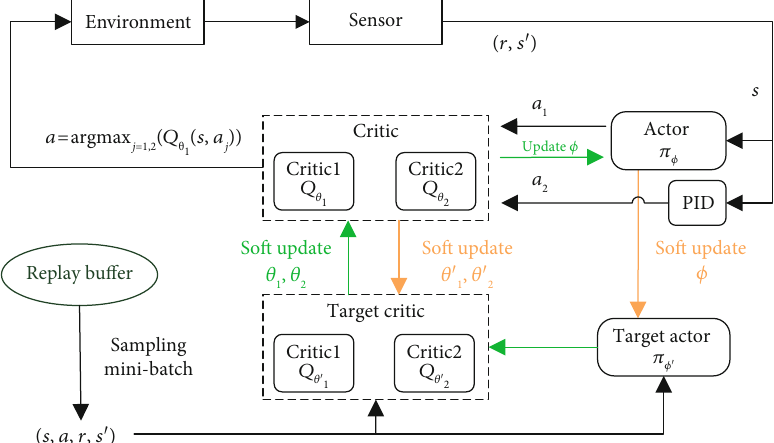
Figure 3: Structure of PID-Guide TD3.